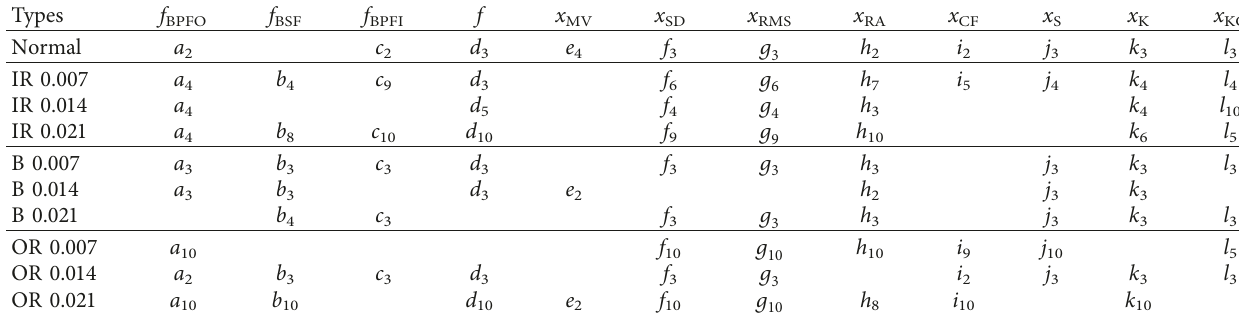
Table 5: Results of mining association